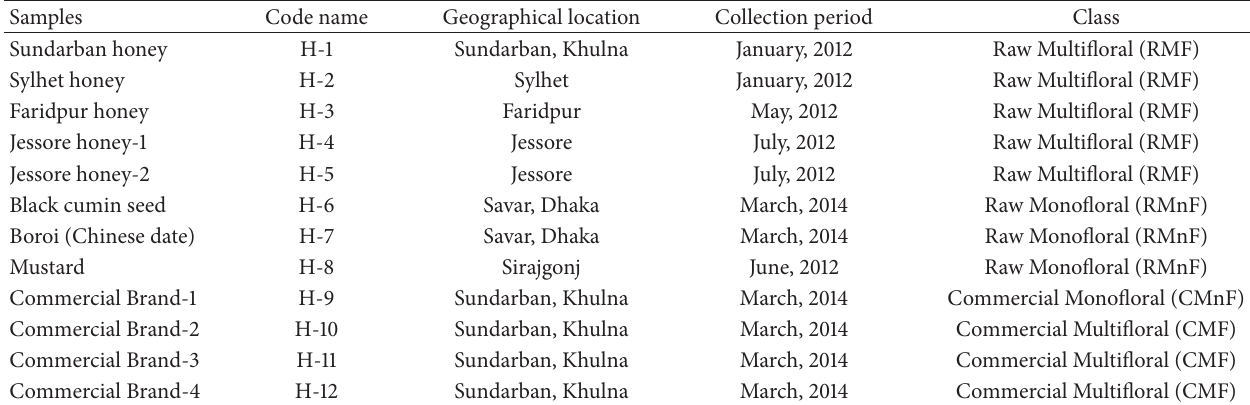
Table 1: Honey samples from the different regions of